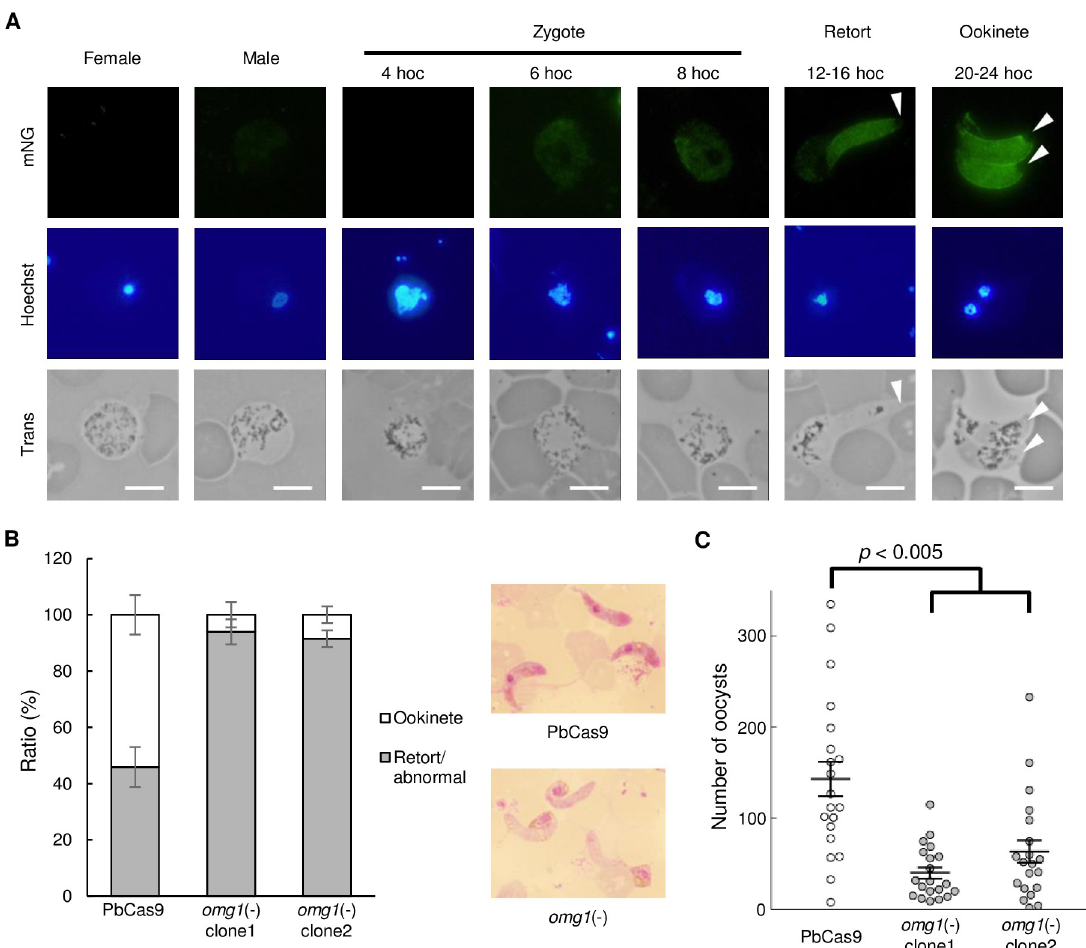
of ookinetes and retort-form/abnormal zygotes to all fertilized cells in PbCas9 and omg1 (-) at 16 hoc. Right side of the figure shows Giemsa-stained images of ookinetes at 16 hoc in PbCas9 (top) and omg1 (-) (bottom). Error bars indicate the standard error of the mean (n = 3). (C) Number of midgut oocysts at 14 days post infection for PbCas9 and omg1 (-). Lines indicate the mean values and the standard error (n = 20). The p -value on the graph was calculated by Student’s